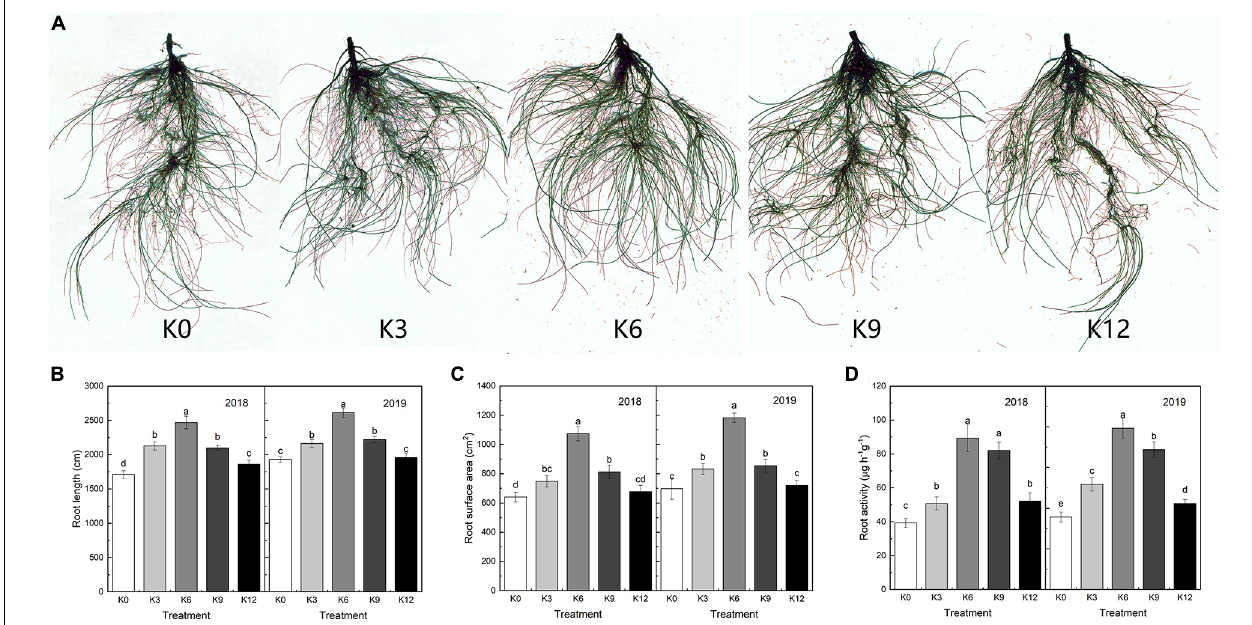
FIGURE 1 | Root morphology (A) , root length (B) , root surface (C) , and root activity (D) of M9T337 seedlings treated with K0 (0 mM K + ), K3 (3 mM K + ), K6 (6 mM K + ), K9 (9 mM K + ), or K12 (12 mM K + ) in 2018 and 2019. Each treatment had three biological replicates and the assays were repeated three times. Vertical bars indicate ± SD ( N = 3). Different letters indicate statistically significant differences ( P <